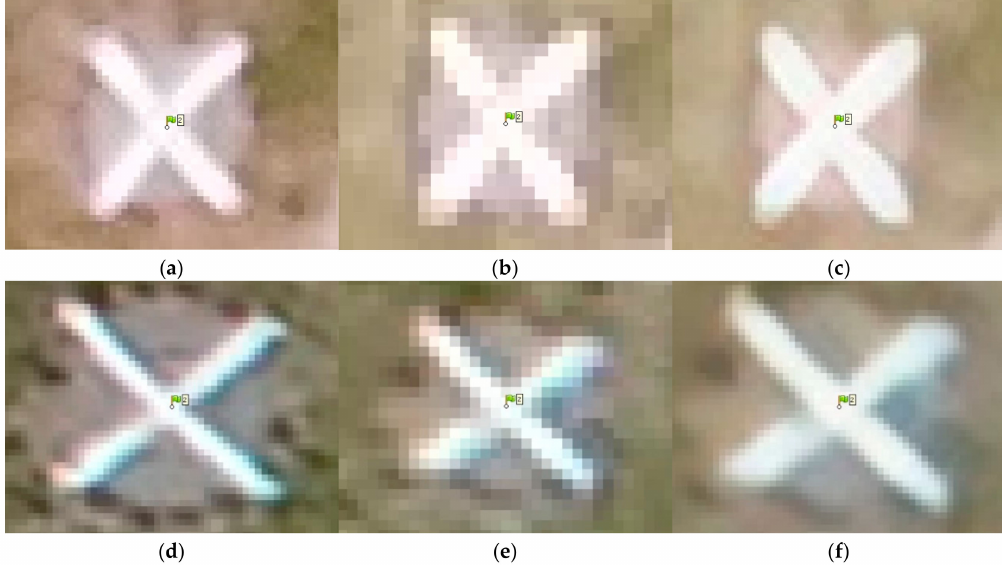
Figure 3. Images of ground-control points from the Mavic Pro: ( a ) GCP-2 at 55 m, ( b ) GCP-2 at 110 m, and ( c ) GCP-2 at SR and from the Phantom 4 Pro: ( d ) GCP-2 at 55 m, ( e ) GCP-2 at 110 m, and ( f ) GCP-2 at SR. SR: super resolution.